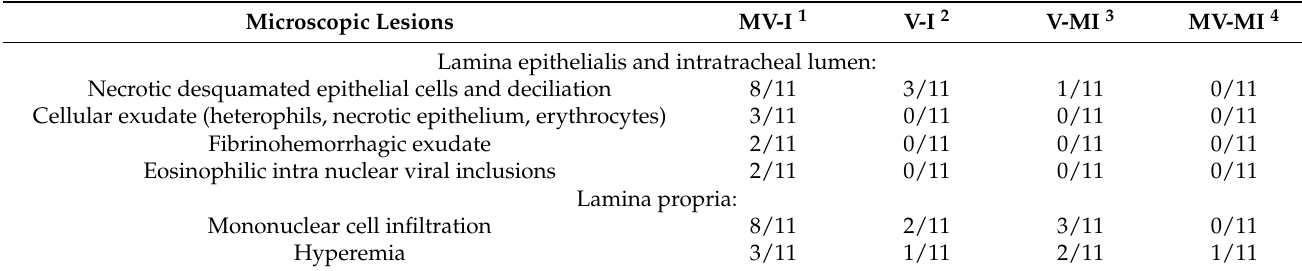
Table 2. The mean microscopic lesions detected in 4 groups.